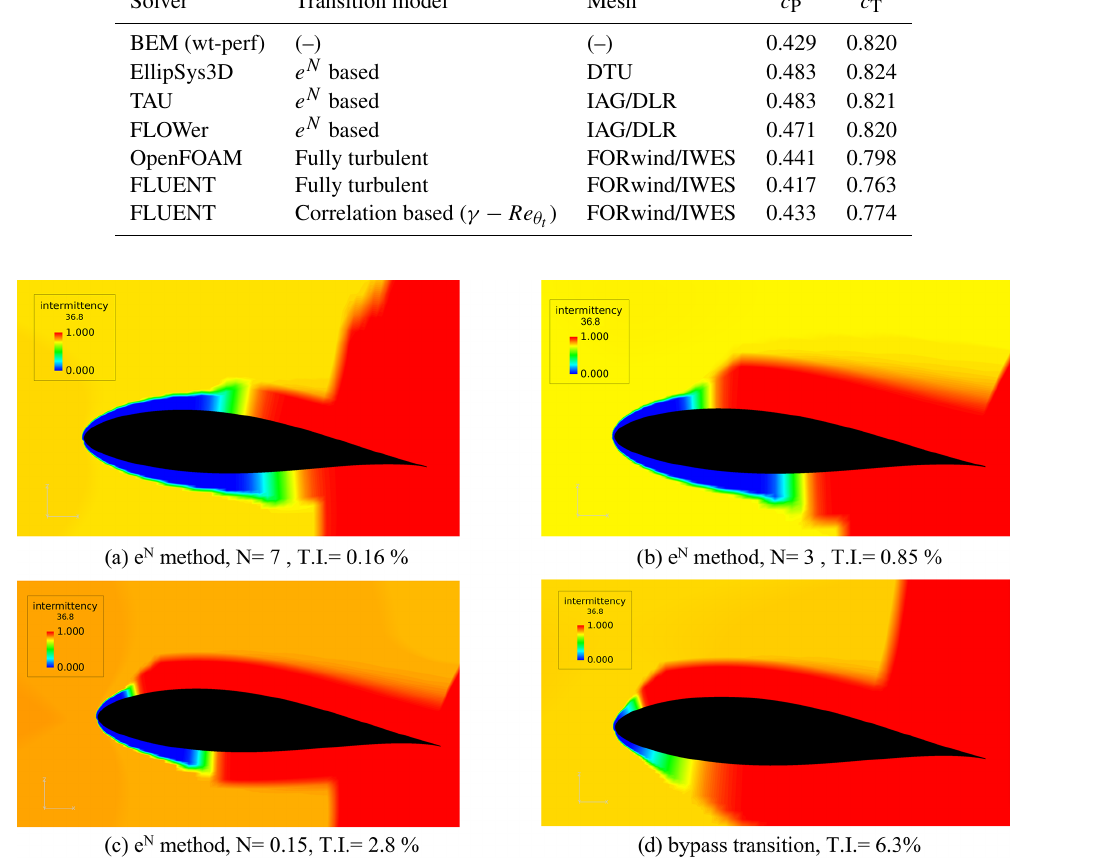
Figure 13. Intermittency contours for the case at w = 6 . 3ms − 1 and p = 4 . 75 ◦ for the blade section at 36.8m from the hub. The blade section results are obtained from the EllipSys3D URANS full rotor